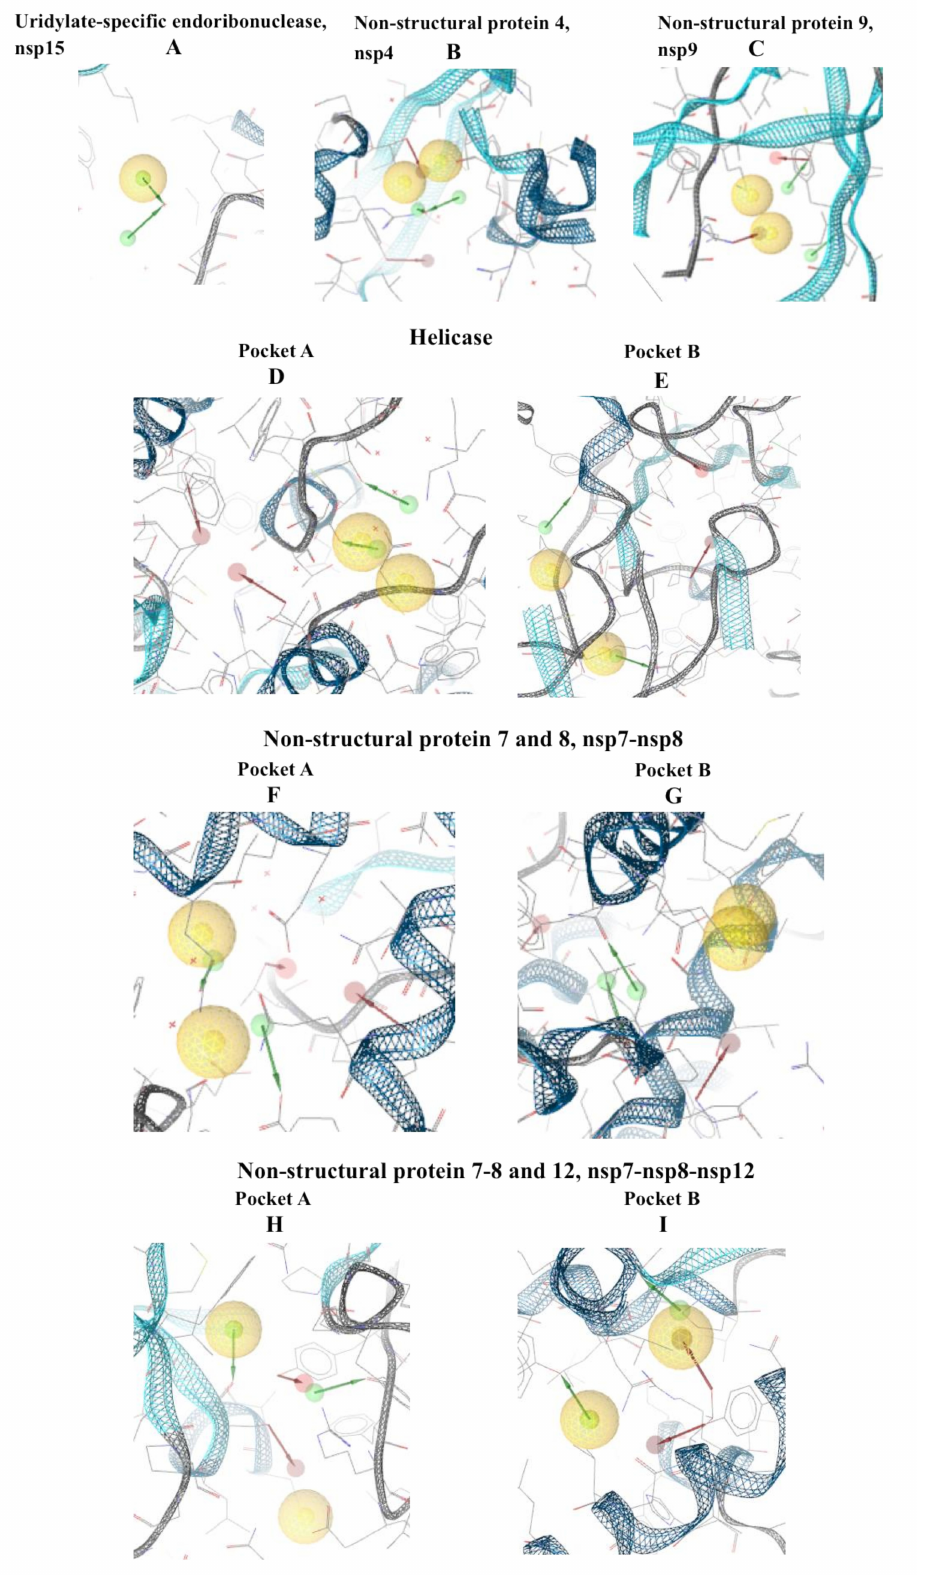
Figure 3. Pharmacophore modeling of the apoproteins. The first step was to find putative active sites, then the pharmacophore models were built in the identified pockets. Four of the structures had two active sites. ( A ) Uridylate-specific endoribonuclease, nsp15; ( B ) nsp4; ( C ) nsp9; ( D ) Helicase pocket A; ( E ) Helicase pocket B; ( F ) nsp7-nsp8 pocket A; ( G ) nsp7-nsp8 pocket B; ( H ) nsp7-8-12 pocket A; ( I ) nsp7-8-12 pocket